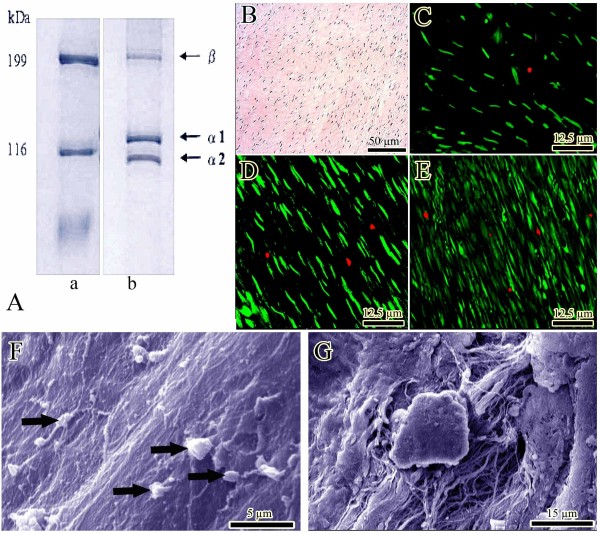
In vitro tests (Results section: Initial tests of the scaffold). (A) SDS-PAGE images of type I collagen using 6% poly-acrylamide gel to examine the purification of collagen extracts. Lane a: molecular marker, lane b: bovine collagen. (B) Histologic section of the constructs after 20 days of cell culture. The proliferating fibroblasts are infiltrated to the implant and proliferated. (C-E) Cell viability was determined by live/dead cell assay using fluorescein diacetate (live) and propidium iodide (dead). (C-E) shows day 5, 10 and 20 after cell seeding. Almost all of the fibroblasts are green, indicating the cells are live. The lack of Propidium iodide stained dead cells (red) supports the idea that normal rat fibroblasts have attached to the scaffold and that the majority of the cells are viable. (F&G) Surface and inside of the collagen implant after 20 days of cell seeding, respectively. The cells proliferated (arrows) and produced matrix.